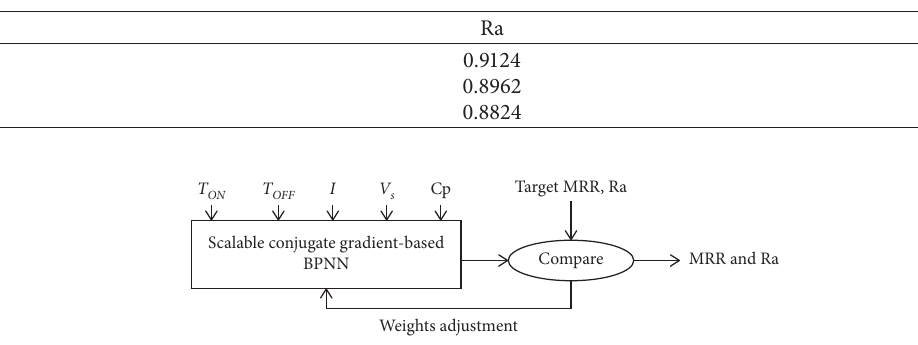
Table 8: Residuals for all performance parameters.